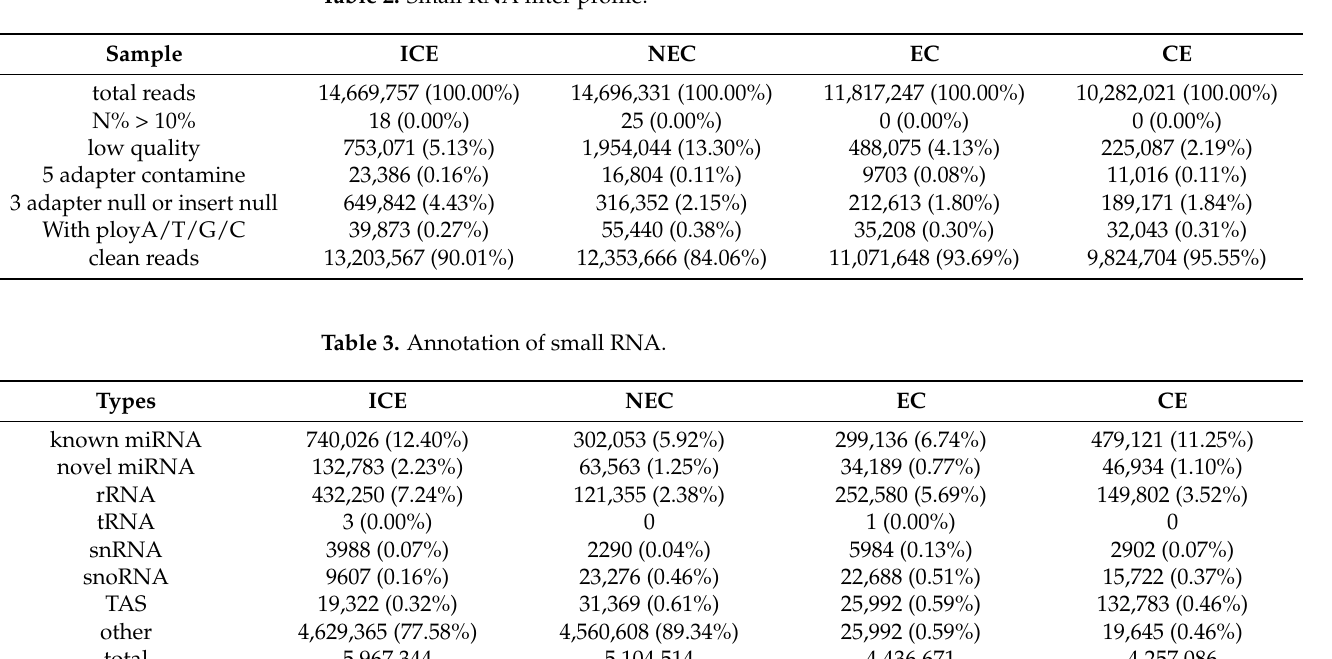
Table 2. Small RNA filter profile.